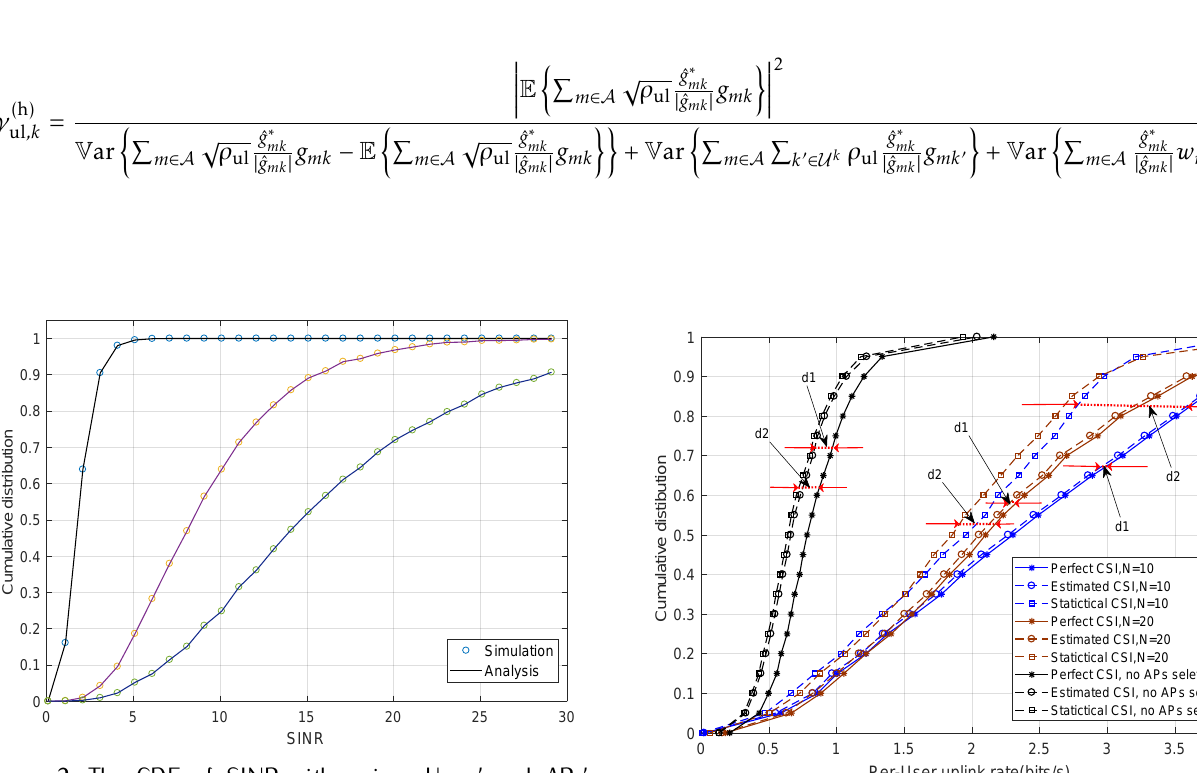
Figure 2. The CDF of SINR with various Users’ and APs’ locations